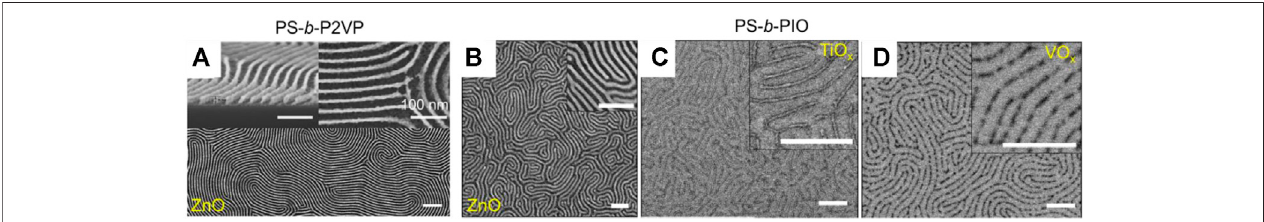
FIGURE6|(A) SEMmicrographs depicting ZnOnanowire patterns synthesizedviamicrodose-in fi ltration-synthesis intoself-assembled PS- b -P2VP. Reproduced with permission from ref (Subramanian et al., 2019) SEM micrographs of (B) ZnO; (C) TiO x ; and (D) VO x synthesized via in fi ltration into PS- b -PIO. Reproduced with permission from ref (Yi et al.,